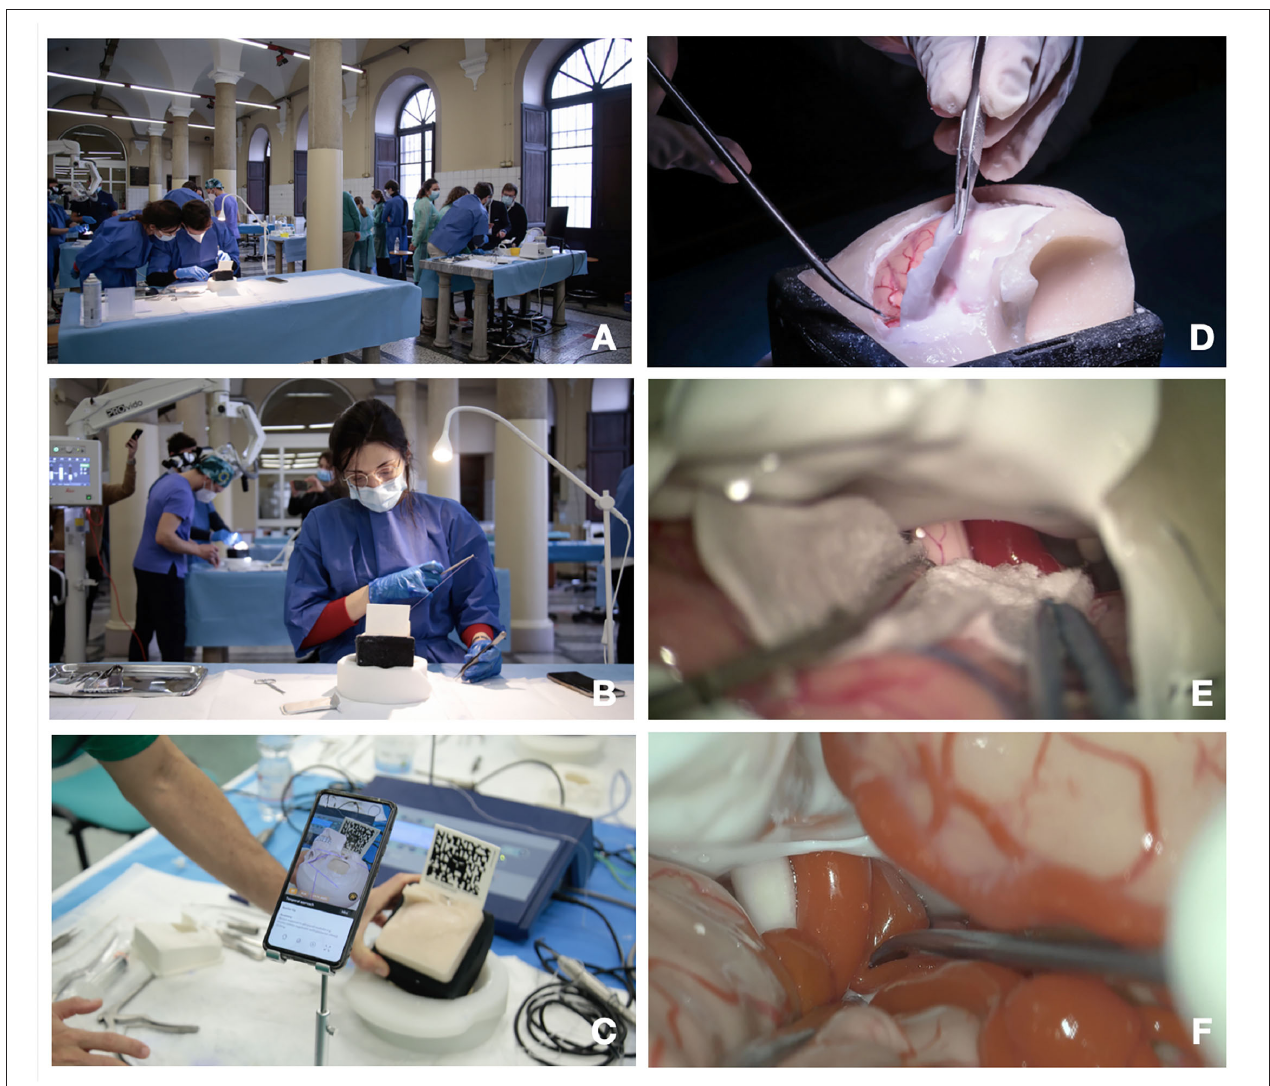
FIGURE 1 | (A–E) Training steps. (A) Training laboratory set up; (B) suturing exercise; (C) augmented reality (AR) for craniotomy and approach planning; (D) dura opening on the pterional approach simulator box; (C) microscopic intradural phase through pterional approach with gentle brain retraction; (E,F) microscopic exploration and dissection through pterional approach of the carotid artery, optic nerve, and sylvian